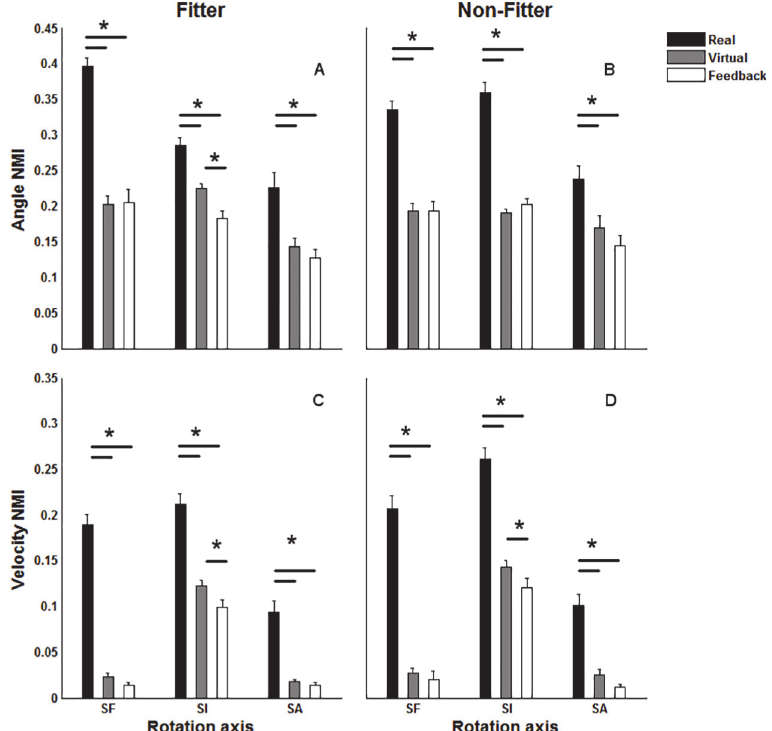
Fig 5. The mean and standard error of normalized mutual information (NMI) between the angular trajectories and velocity profiles within real environment and a representative trajectory, i.e., the median of traces across all subjects (Real). For kinematic trajectories of an arbitrary subject ( S i ), we ,RE S (cid:1) ) where ( S (cid:1) ) indicates the representative trajectory across the subject pool. NMI computed NMI ( RE S i between the virtual and virtual with force feedback trajectories on one hand and their corresponding trajectories within the real platform on the other hand (Virtual and Feedback) NMI ( RE S VEF S i ), respectively. The figures in each column illustrate the outcomes for each of the object types ( and “ non-fitter ” ). SF, SI and SA stand for shoulder flexion, internal rotation and abduction, respectively. * indicate a significant pairwise comparison between Real, Virtual and Virtual environment with feedback (Feedback) (p <